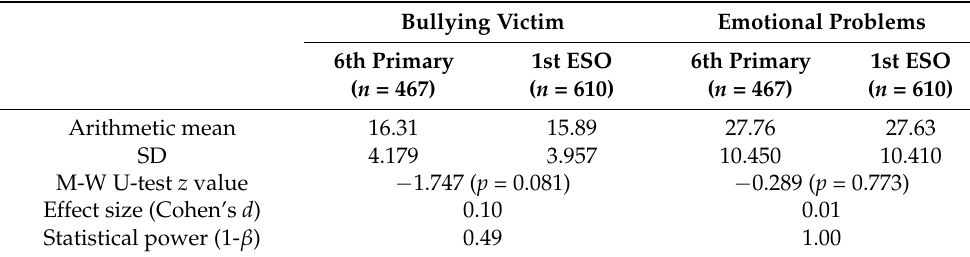
Table 7. Comparison of means according to education level.